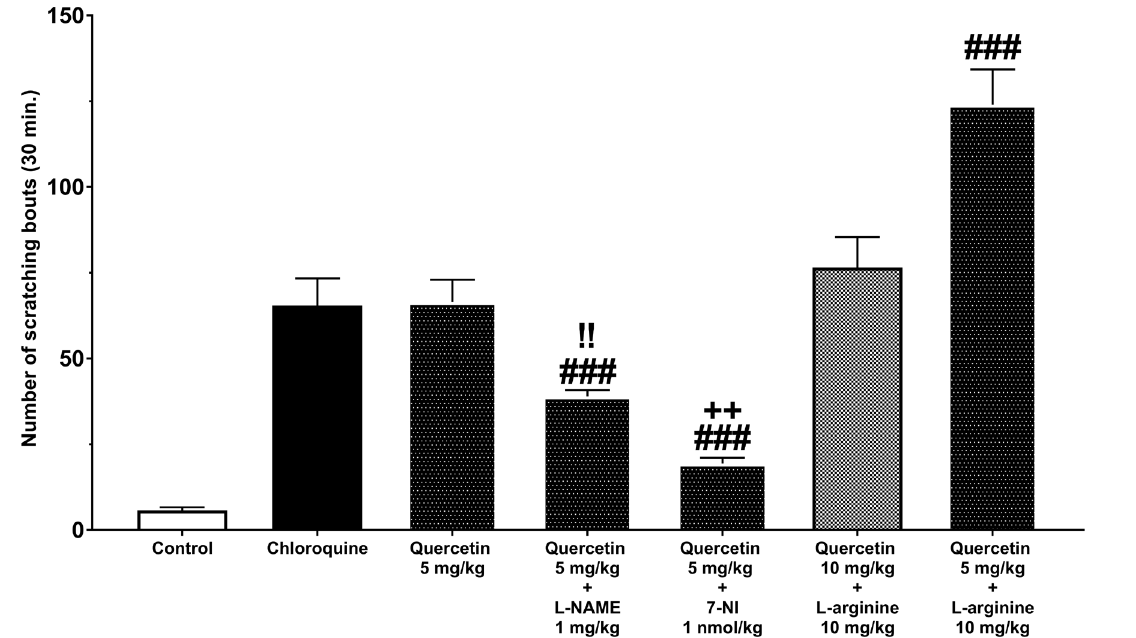
FIGURE 4 - Evaluation of the possible role of NO in suppressive effect of quercetin. But co-administration of the sub-effective dose of quercetin with sub-effective doses of L-NAME (1 mg/kg) and 7-NI (0,16 µg /kg) significantly suppressed the chloroquine- induced number of the scratching bouts. Additionally, a sub-effective dose of 7-NI more significantly decreased the number of chloroquine-induced scratching bouts, while an effective dose of L-arginine (10 mg/kg) significantly enhanced the number of chloroquine-induced scratching bouts when co-administered with a sub-effective dose of quercetin (5 mg/kg). All data represented as mean±SEM. All data represented as mean±SEM. ###p<0.001 versus chloroquine and !!p<0.01 versus quercetin (5 mg/kg) and !!p<0.01 versus quercetin (5 mg/kg) + 7-NI (0,16 µg/kg)